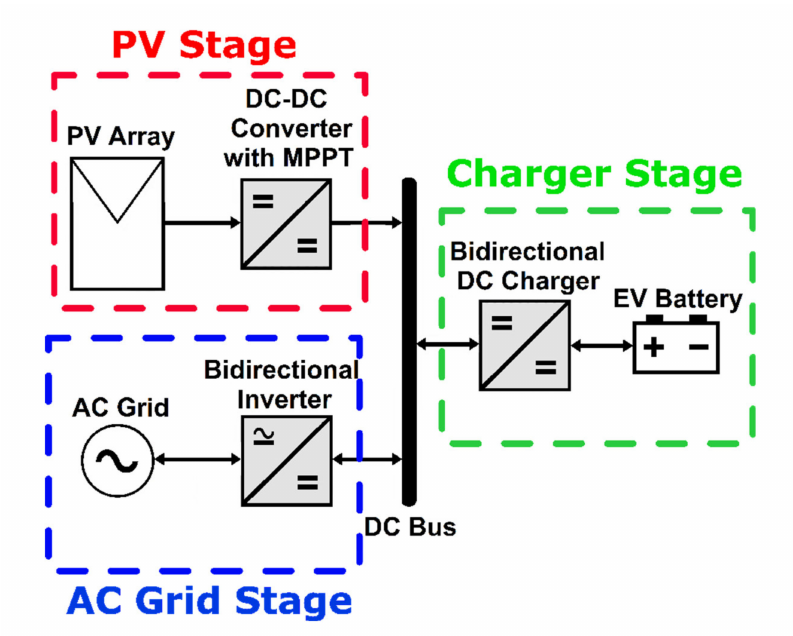
Figure 4. Overall PV / grid-tied electric vehicle (EV) charging system structure